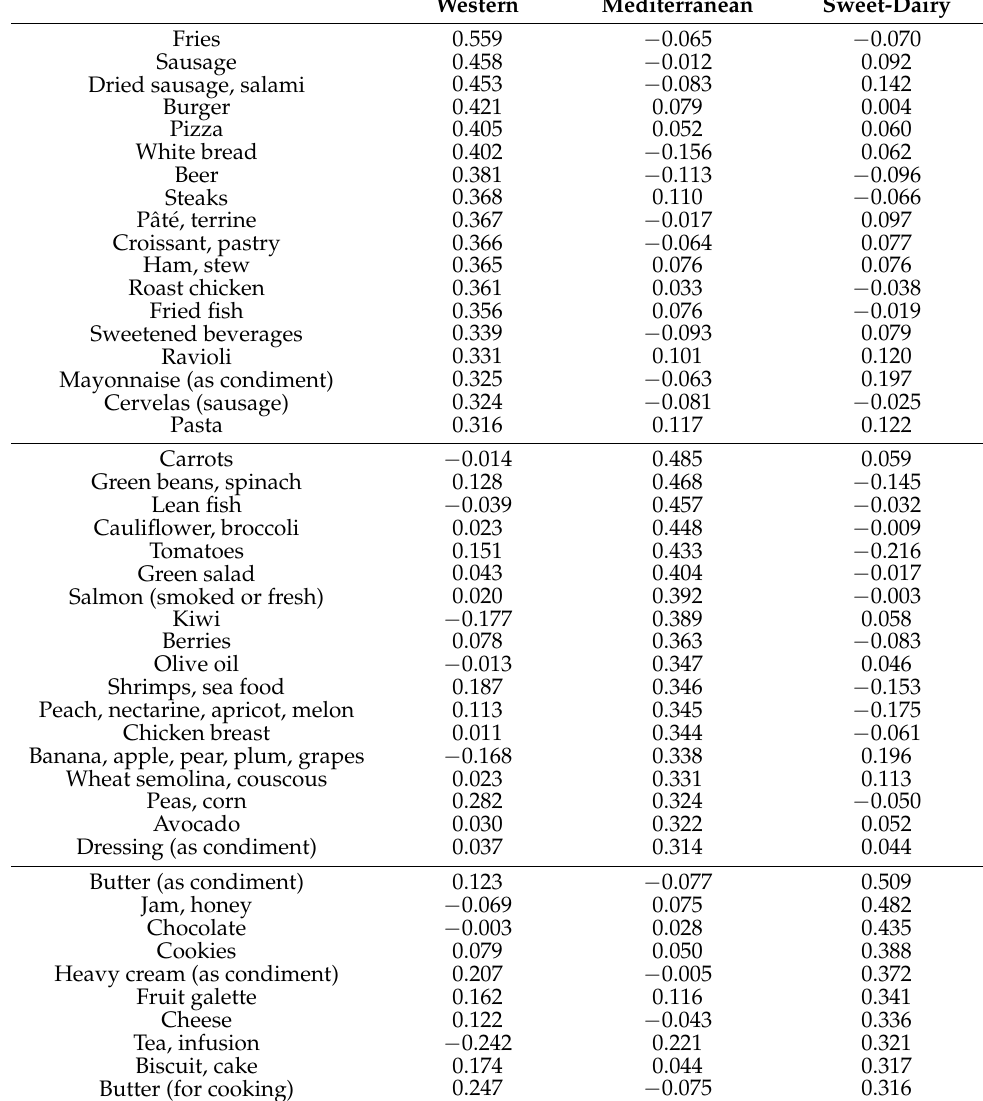
Table 1. Selected explanatory factor loadings for the 3-factor model (after promax rotation, n =